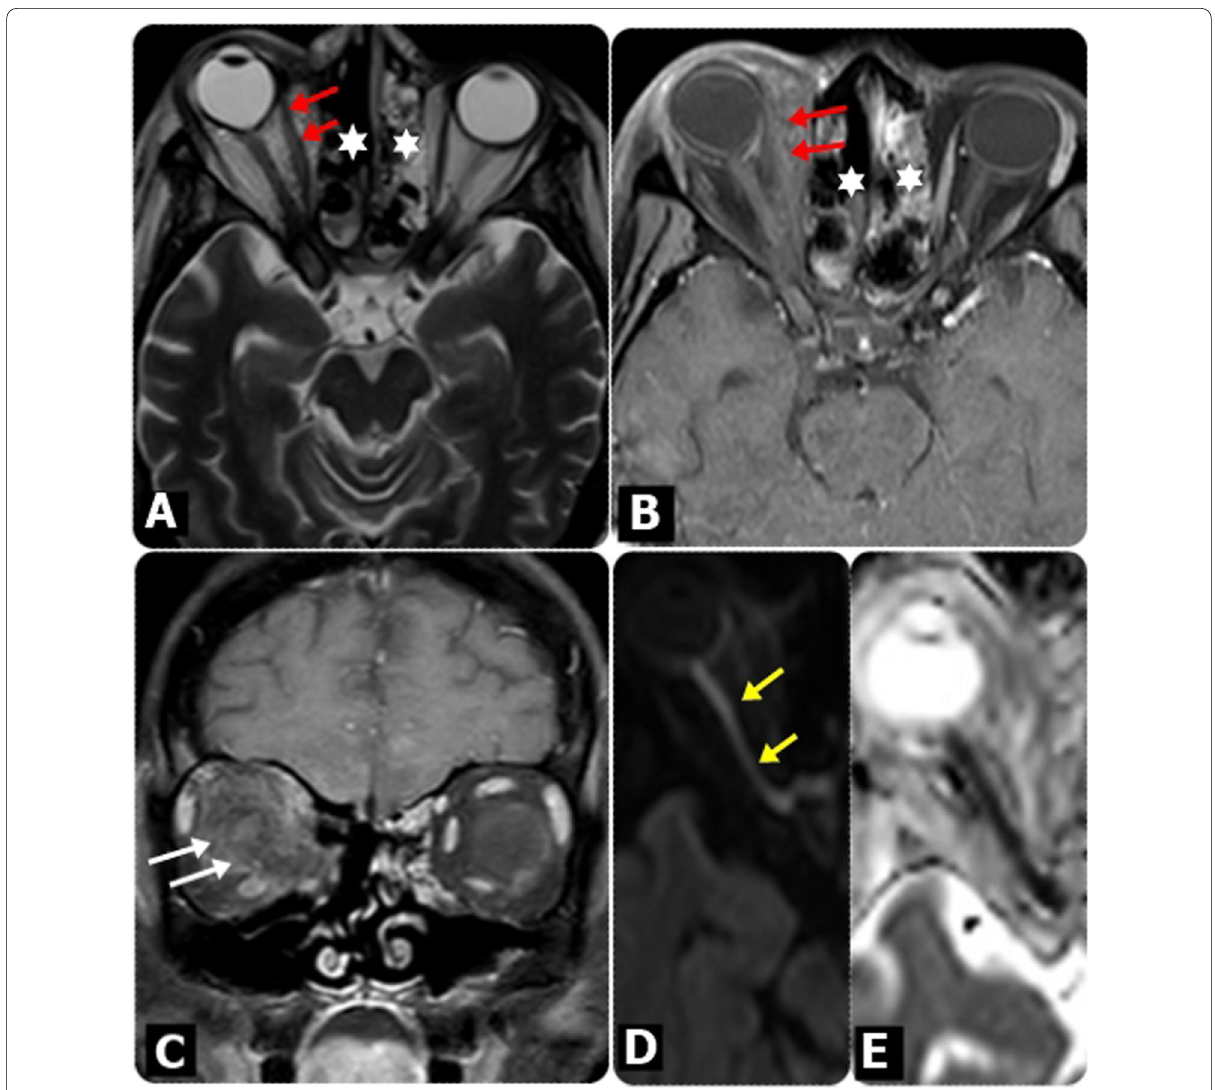
Fig. 7 MRI findings in diabetic female patient, 65 years old, presented mainly with Rt. eye proptosis, with decreased in vision, following COVID‑19. A Axial T2W as well as B Axial and C Coronal post‑contrast fat‑saturated T1WI showed bilateral ethmoidal sinusitis (asterisks), with extension of the inflammatory process to the Rt. orbit, resulting in proptosis of Rt. eye globe, with posterior globe tenting, as well as Rt. periorbital and eyelids edema. There is retro‑orbital fat stranding (White arrows) and thickened and enhanced Rt. extra‑ocular muscles (red arrows). Rt. optic nerve showed restricted diffusion on DW images (Yellow arrows) at b‑value 1000 ( D ) and apparent diffusion coefficient (ADC) map ( E ) in keeping with Rt. optic nerve